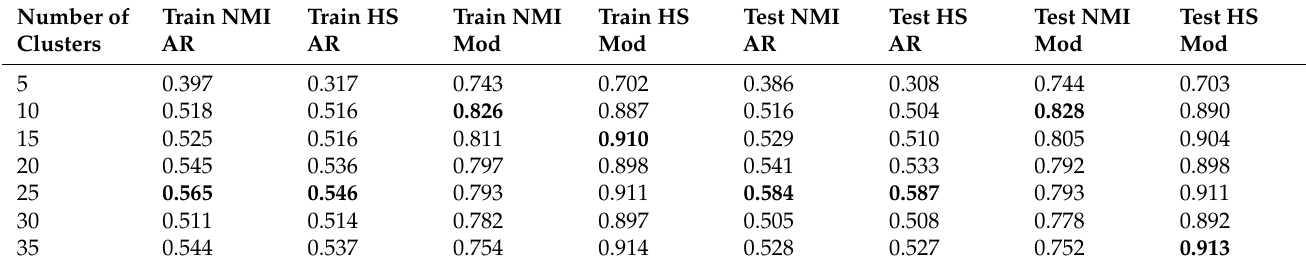
Table 1. Clustering performance obtained for varying numbers of clusters K on train/test data with respect to the two selected labels ( Mod and AR ), using the following loss-function weights: α = 0.1, β = 1 and γ = 10. The best result in each column is printed in boldface. Silhouette score is not shown in this table because it does not depend on the number of clusters.